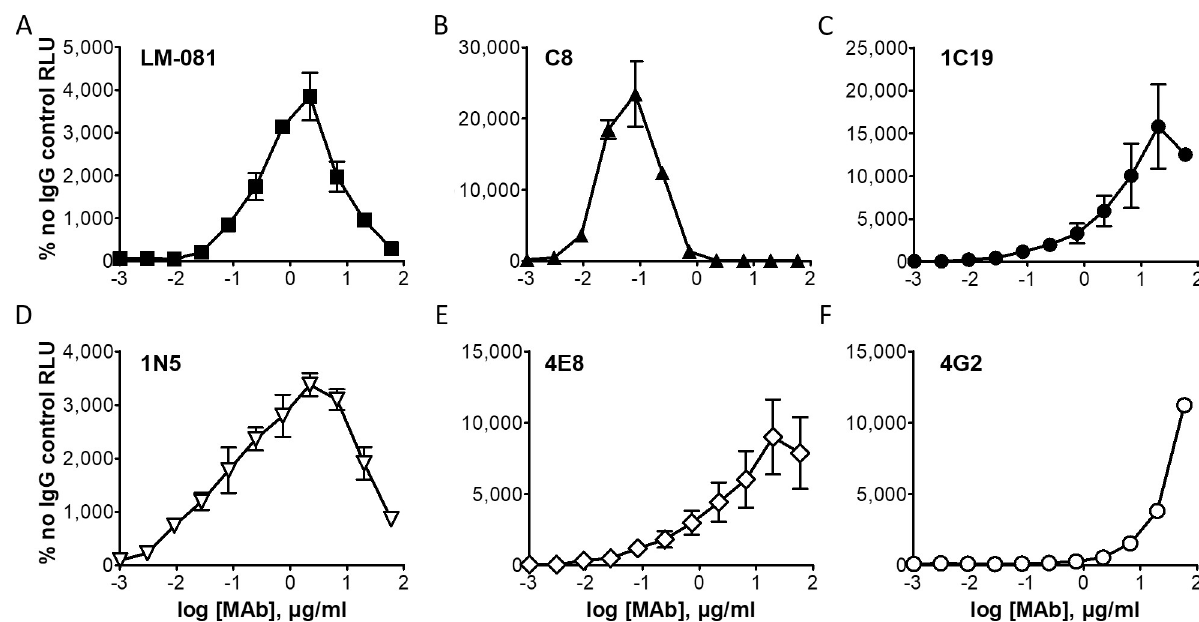
Fig 6. Antibody-dependent enhancement (ADE) of ZIKV infection. ZIKV RVPs were mixed and incubated for 1 h at 37˚C with serial dilutions of ZIKV-reactive neutralizing MAbs LM081, C8, 1C19 (filled symbols) or non-neutralizing MAbs 1N5, 4E8, 4G2 (unfilled symbols). K562 cells were then added to each well and incubated for 72 h at 37˚C. Culture medium was removed, cells were lysed, and plates were analyzed for luciferase activity. Each data point is the average of 2 wells and is plotted as a percentage of the no antibody control. Error bars indicate range.